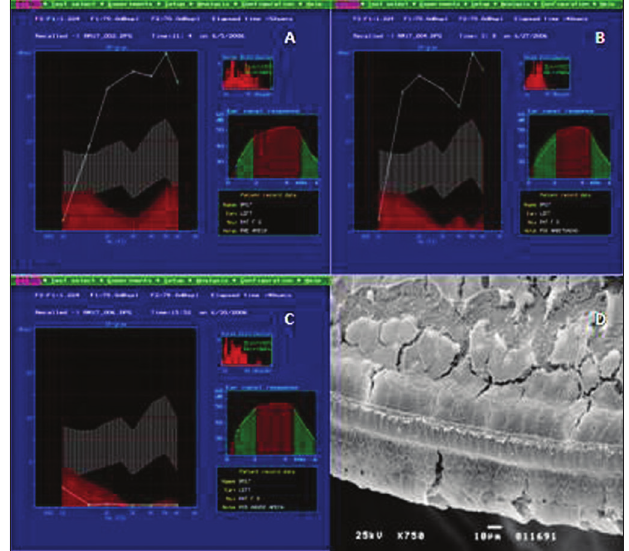
Figura 2. Exemplo de OEA-PD no grupo B. A: pré-exposição, observa- se a manutenção da função auditiva a partir de 1 KHz, com a presença das OEA-PD; B: OEA-PD presentes após tratamento com baixas doses, não lesivas, de amicacina; C: OEA-PD ausentes em todas as frequências testadas após dose lesiva de 400 mg/kg/dia de amicacina por 12 dias; D: Exemplo de MEV no grupo B, mostrando na espira basal destruição de Células Ciliadas Externas. Aumento de